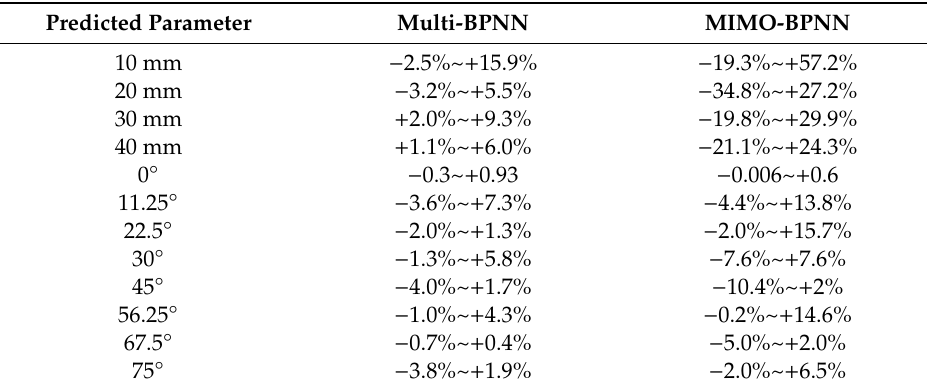
Table 2. Predicted deviation range of the